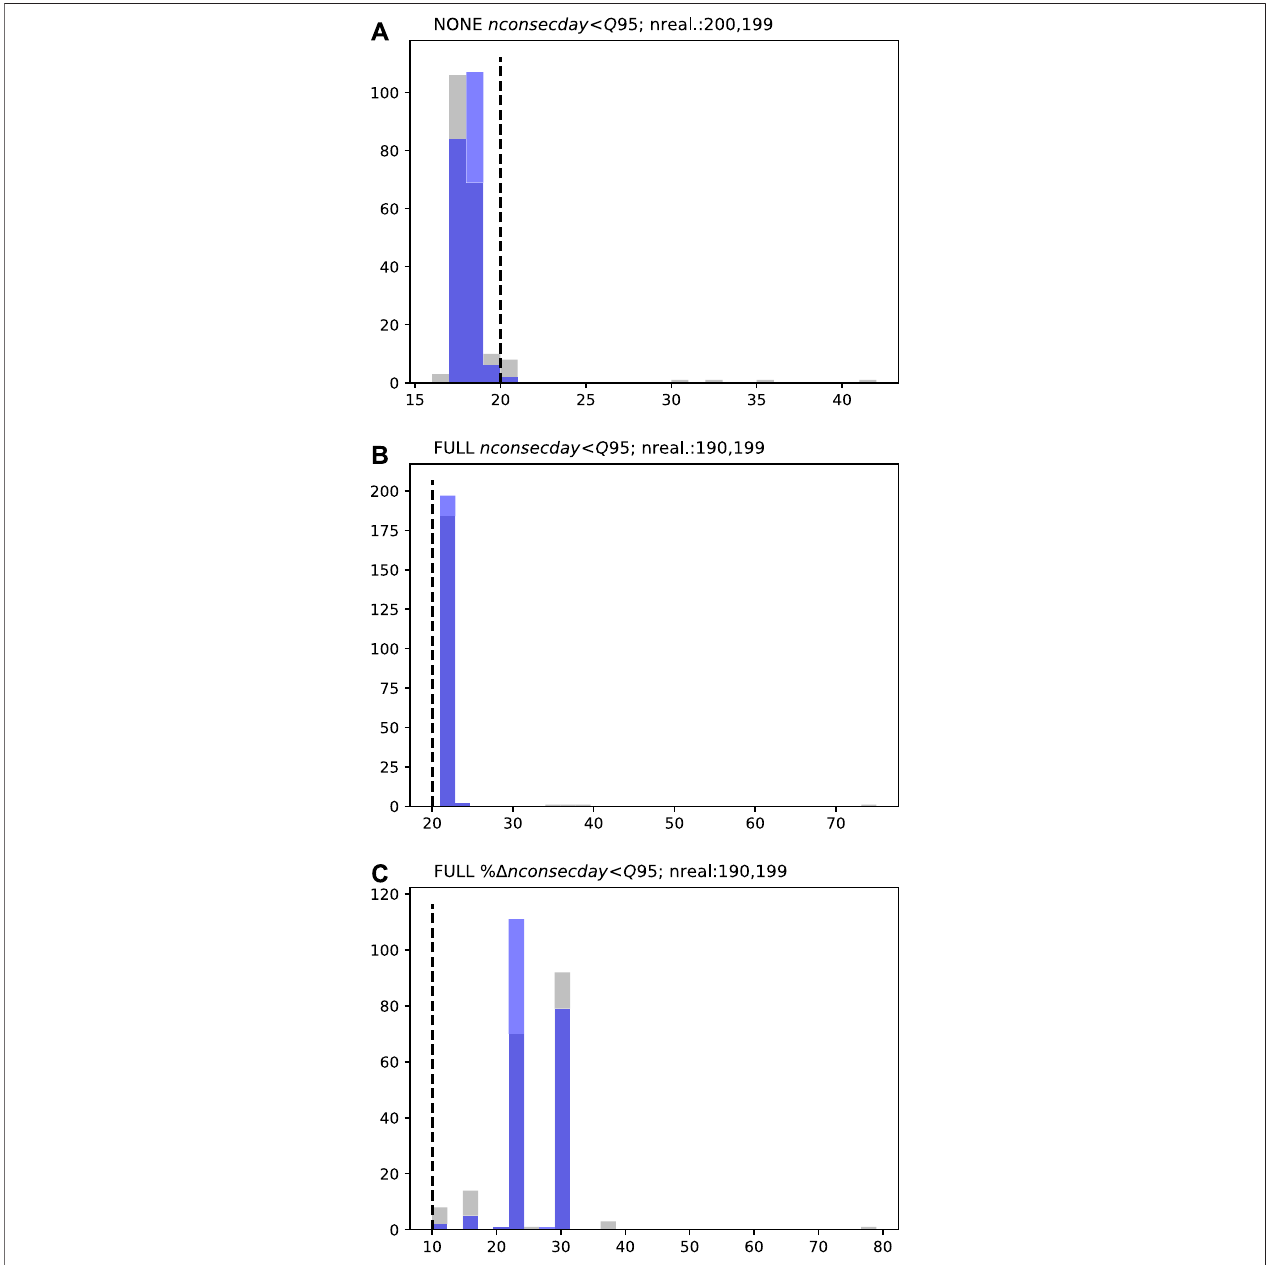
FIGURE 7 | MS1 low- fl ow persistence ( nconsecday < Q95 ; A and B ) and percent change low- fl ow persistence ( %nconsecday < Q95 ; C ) prior (grey) and posterior (blue) forecast PDFs. Dashed black lines represent the respective decision thresholds (20 days in A and B and 10% change in C ). “ NONE ” represents the “ naturalized ” baselineand “ FULL ” the abstractionscenario. “ nreal. ” details the number ofsuccessful realizations (therefore the number of datapoints represented in thePDF) for prior and posterior ensembles, respectively.